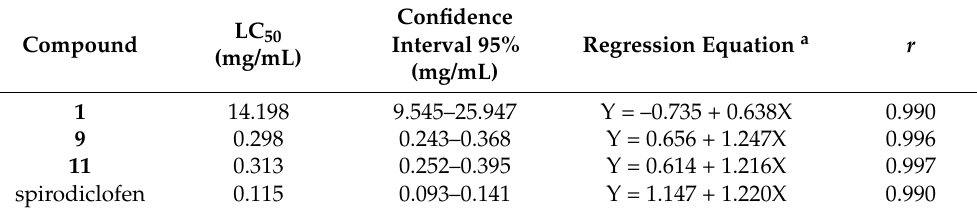
Table 2. Toxicity regression analysis of compounds 1 , 9 , and 11 against T. cinnabarinus at 72 h. Confidence LC 50 Compound (mg/mL)